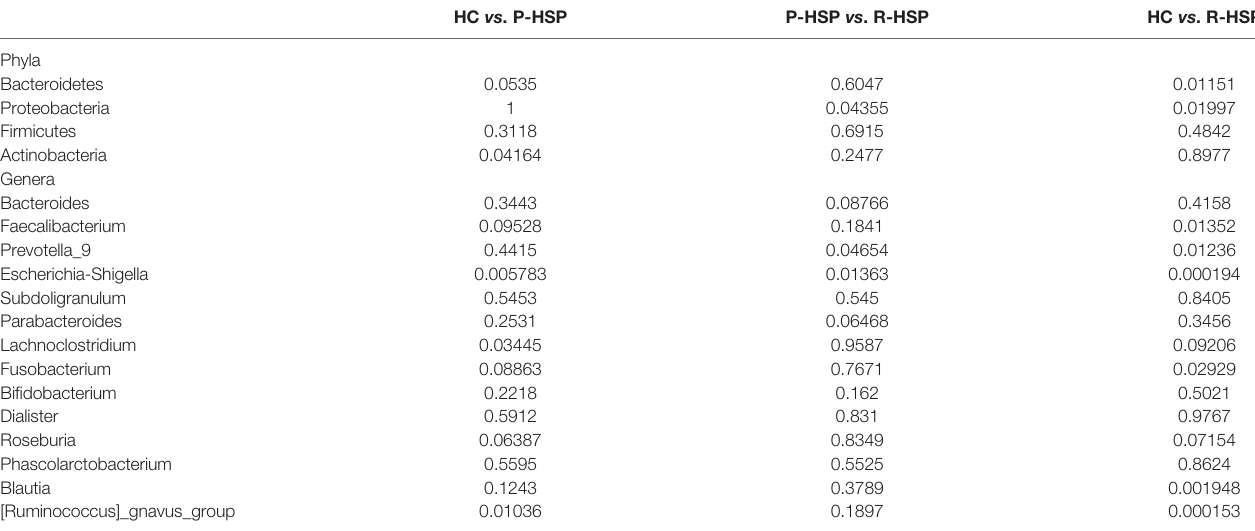
TABLE 2 | P-value statistics of differences among intestinal microbial groups at different taxonomic levels.